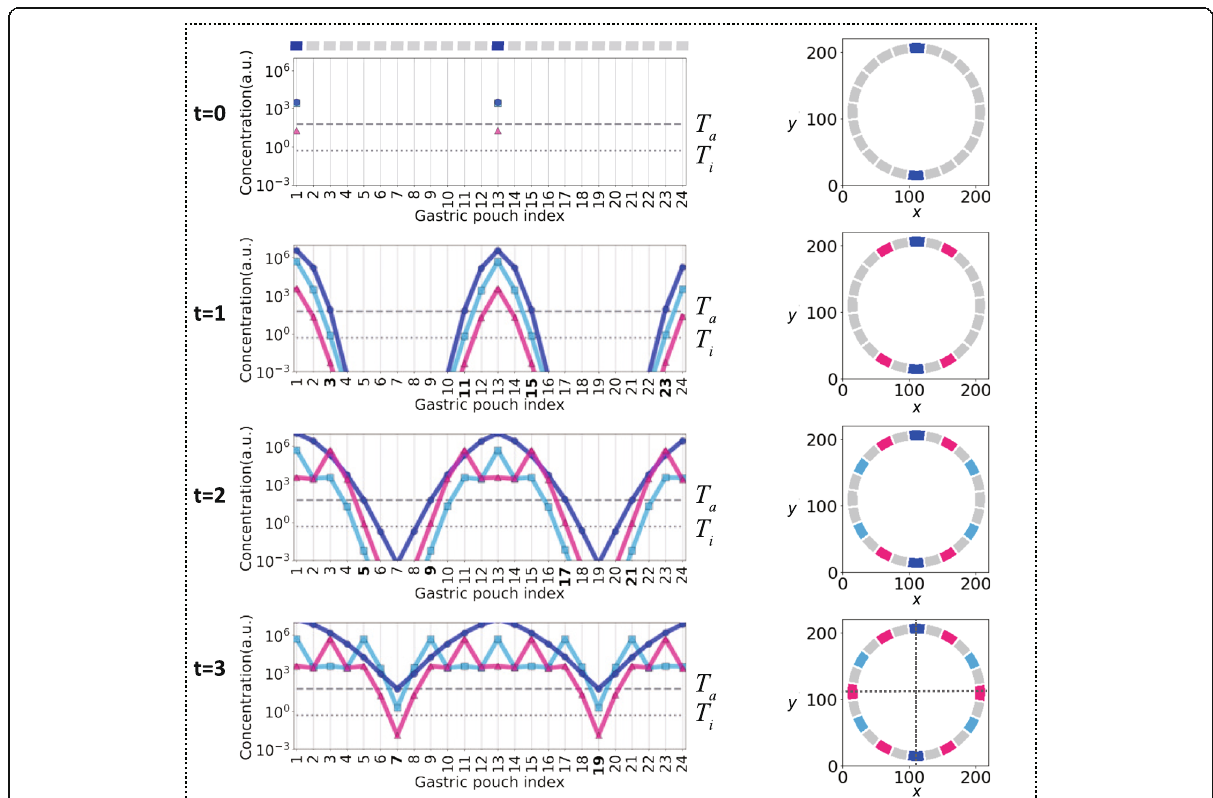
Fig. 6 A biradially symmetrical arrangement for 12-striped individuals (24 pouches) in the model simulation. Temporal evolution of the concentrations of a , b , and c in a semilogarithmic plot (left panel) as a function of the gastric pouch index (Fig. 5f) and 2-D arrangement of specified and nonspecified pouches (right panel). Except for the initial condition (t = 0) of the two PDs positioned oppositely (Fig. 5f), the definitions of the colors, lines, and indexes used in each panel and the model setting are identical to those in Fig. 5g. Following the same rule of irreversible specification in Fig. 5g, pouches neighboring two PDs remain nonspecified pouches due to the suprathreshold of b and c (a > T a , b,c > T i ) (t = 1, gastric pouch index = 2, 12, 14, 24). Adjacent pouches to these pouches, in which the suprathreshold of a was achieved, are specified as P2s due to subthreshold c ( a > T a , b > T i , c < T i ) (t = 1, gastric pouch index = 3, 11, 15, 23). B and C Secretion from P2s surrounding pouches as nonspecified pouches ( a > T a , b,c > T i ) (t = 2, gastric pouch index = 4, 10, 16, 22). Adjacent pouches to these pouches are irreversibly specified as first pouches (P1s) due to the subthreshold of b ( a > T a , b < T i , c > T i ) (t = 2, gastric pouch index = 5, 9, 17, 21). Surrounding